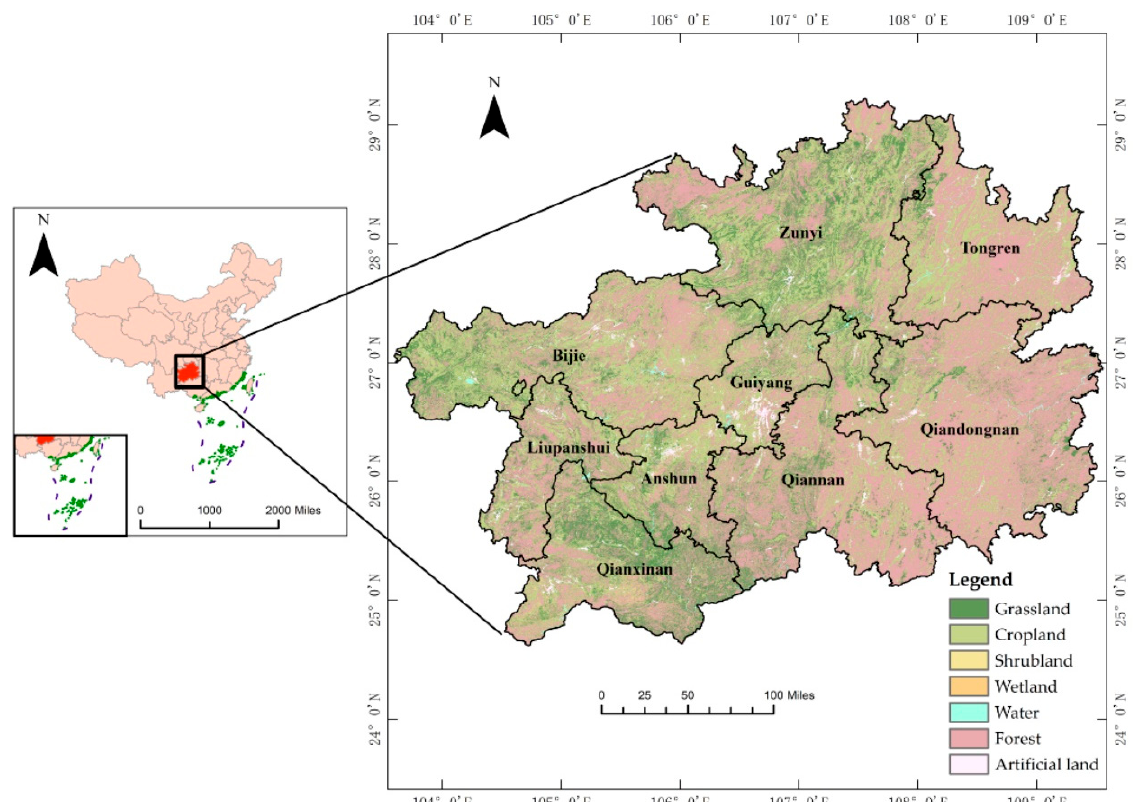
Figure 1. Location and administrative map of Guizhou Province.